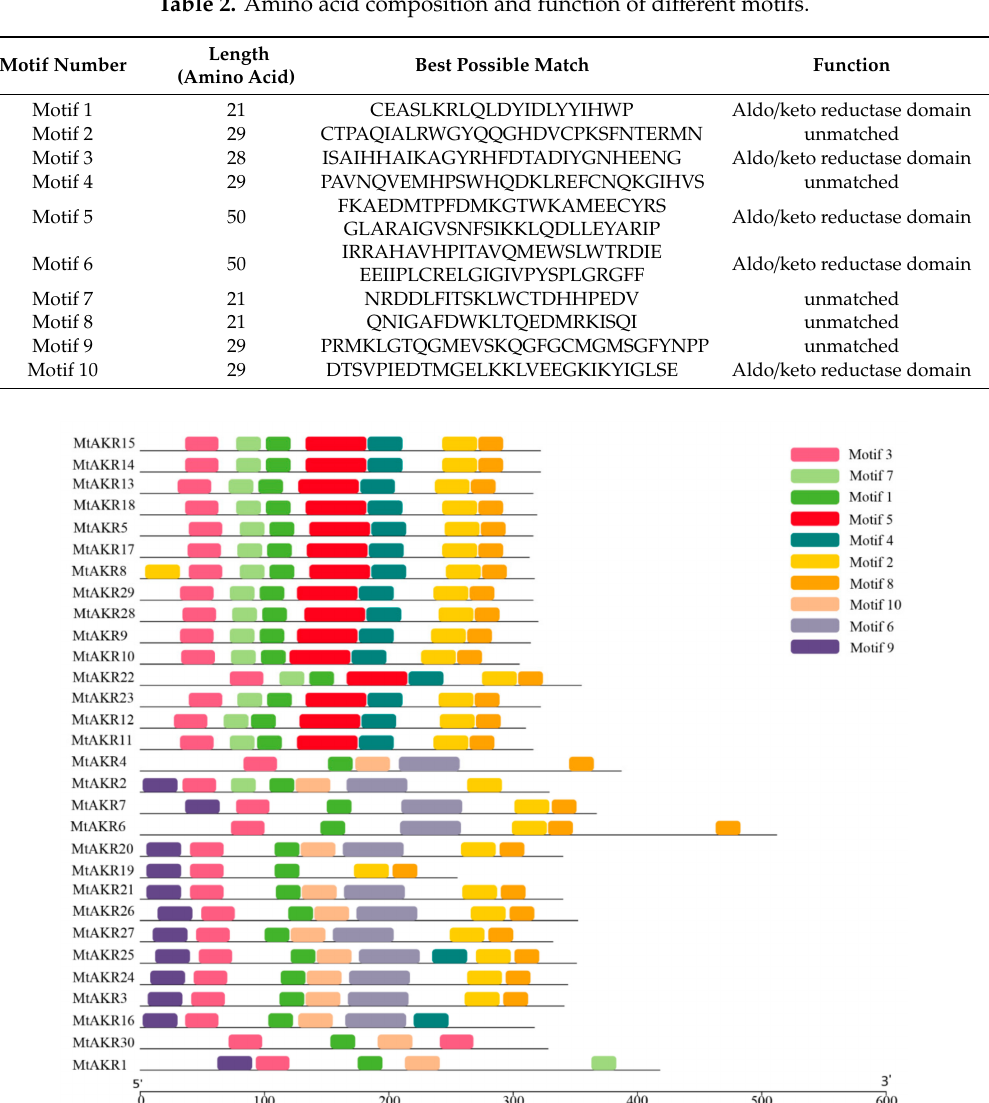
Figure 3. Distribution of the conserved motifs in di ff erent MTAKR s and the logos for each